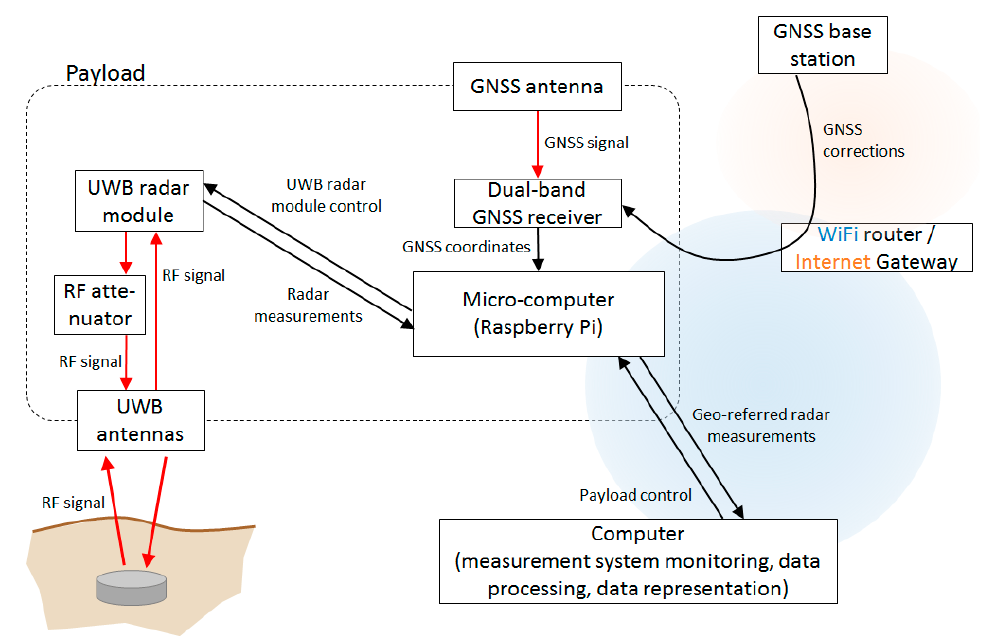
Figure 3. Scheme of the subsystems and devices of the air-launched GPR.